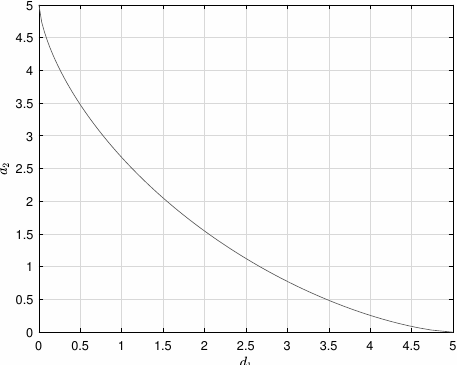
Figure 3. The minimum values of d 1 and d 2 for a 5-unit-long crossbar ( d ) to pass through the channel (with β = π 2